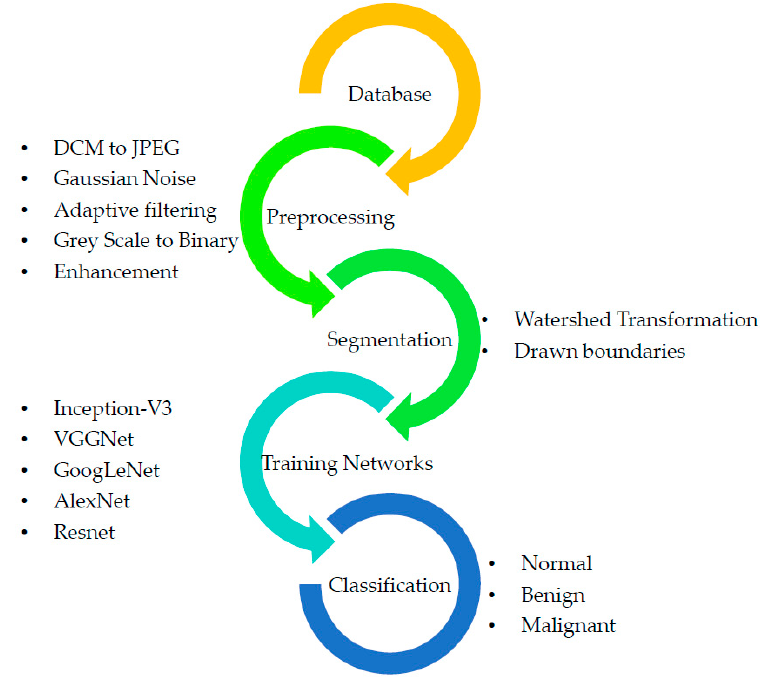
Figure 1 . Proposed methodology .